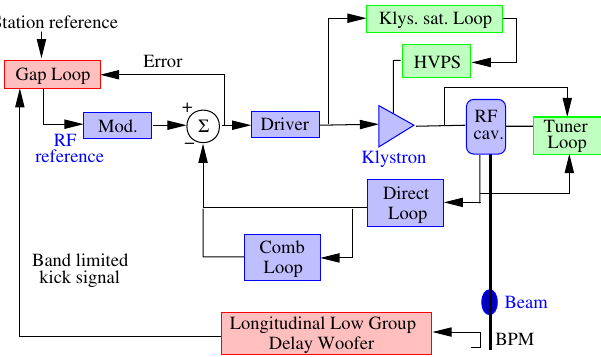
FIG. 1. (Color) System block diagram. Fast dynamics (modeled) appear in blue, slow dynamics (fixed parameters in simulation) in green, and not modeled components in